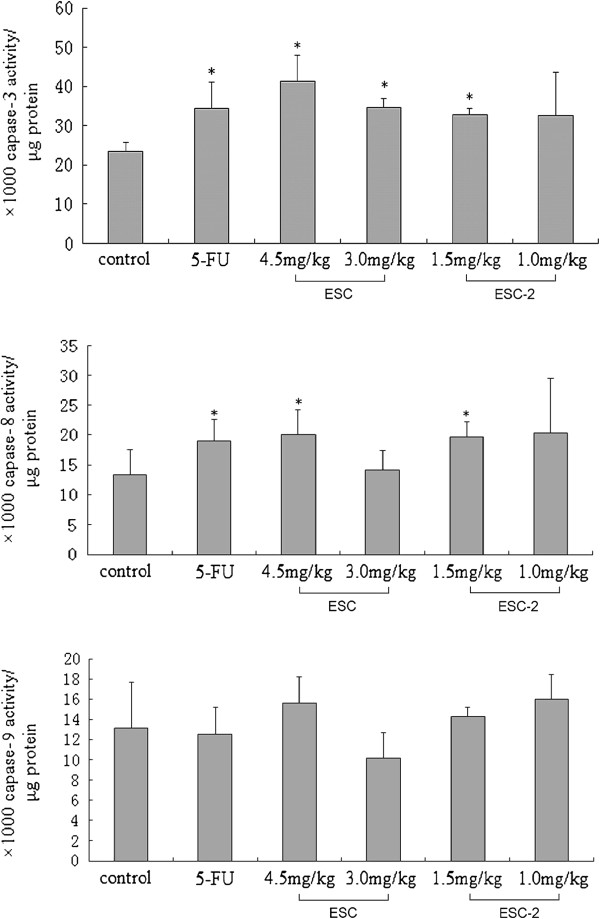
Influence of ESCs on activities of caspase 3, 8, 9 in NCI-H460 cells from implanted hollow fibers. The data were expressed as mean ± SD (n = 6 per group). *p < 0.05, significant versus control group.